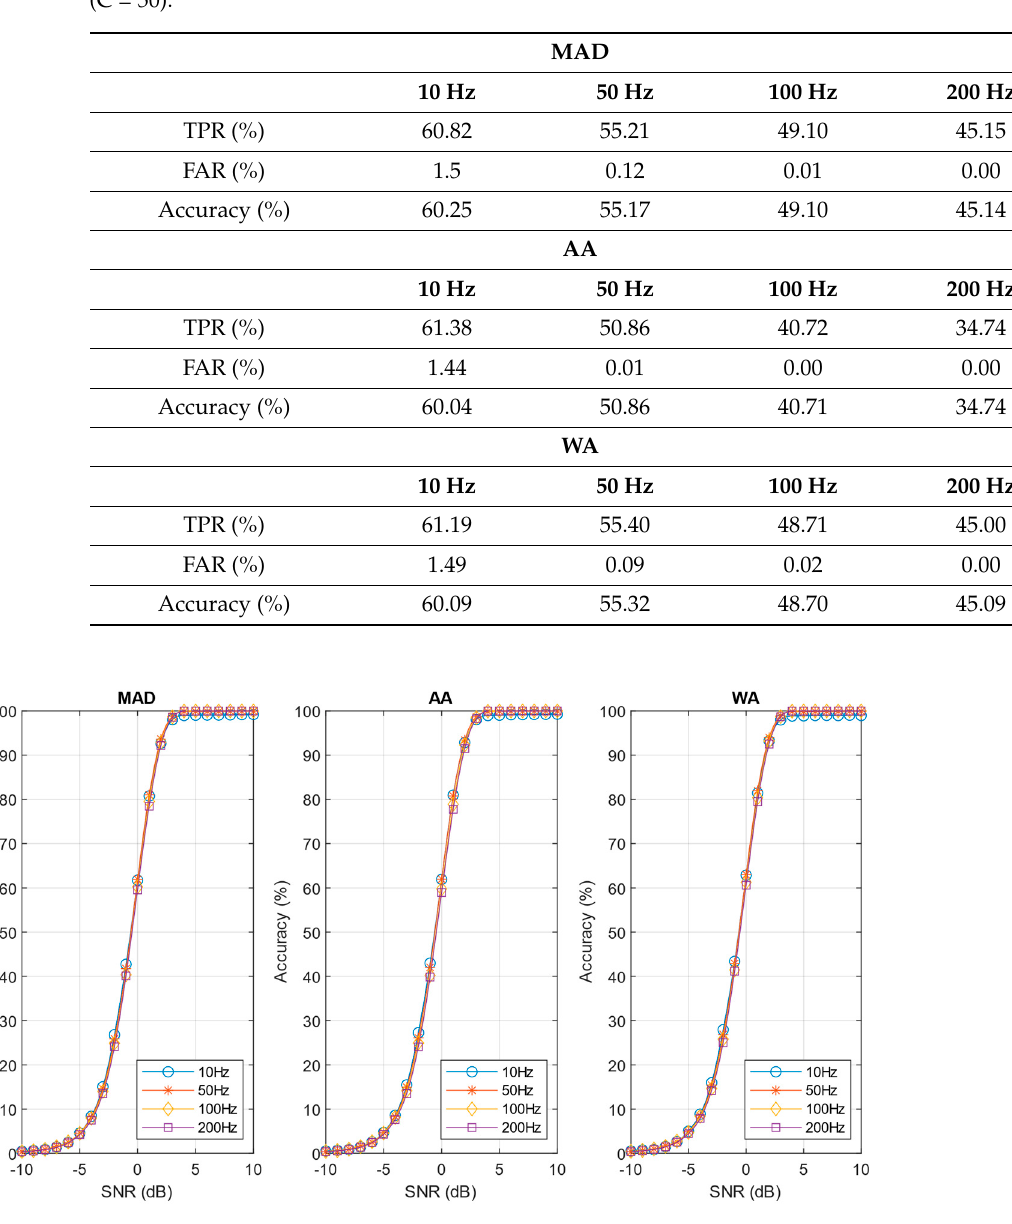
Figure 12. Performances of pre-norm algorithm with the investigated noise estimation techniques. The neuron firing rate varies 10–200 Hz ( C = 7).